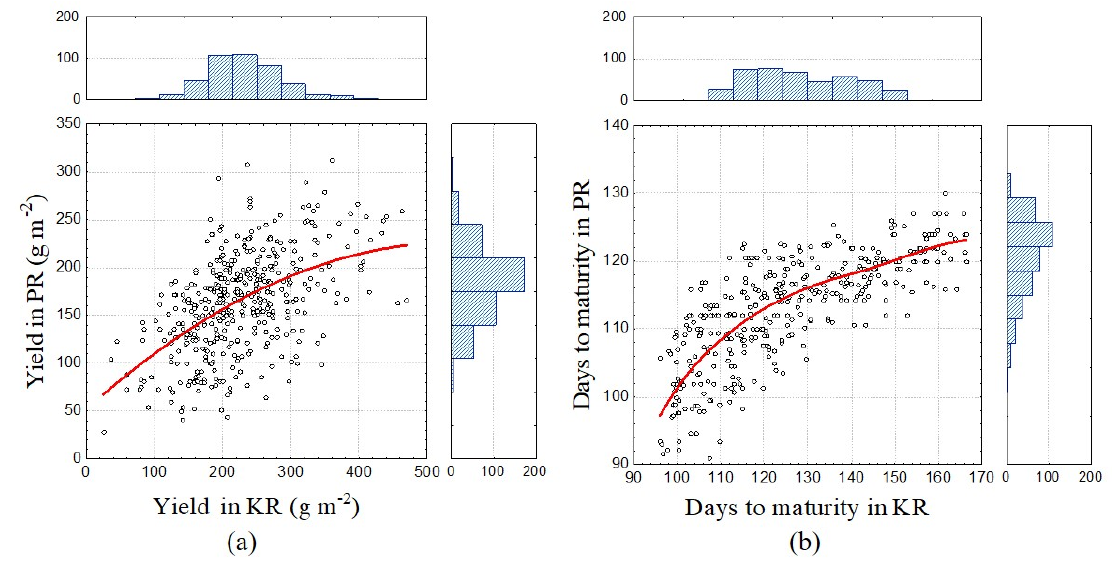
Figure 3. Relation between ( a ) the yield and ( b ) the emergence-to-maturity duration for 424 soybean varieties in Krasnodar (KR) and Primorye (PR) territories. Line—distance-weighted least squares approximation.